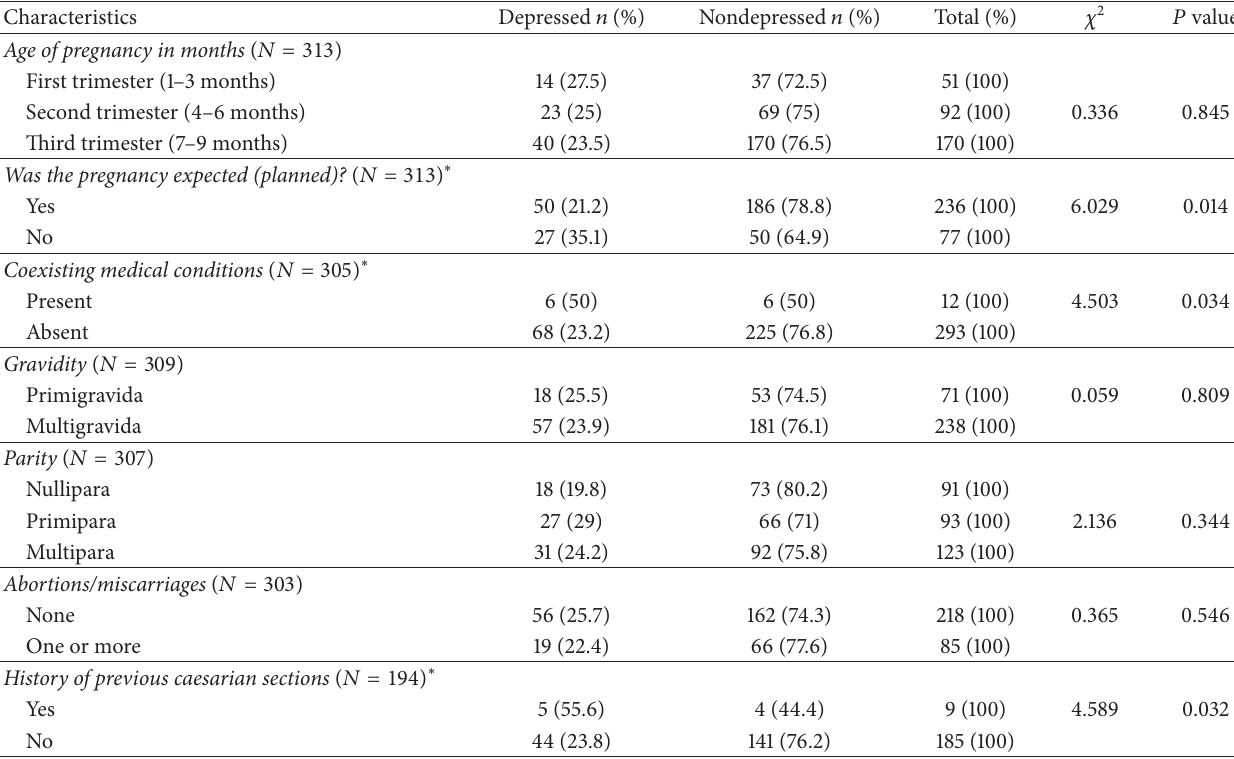
Table 4: Associations between obstetric/gynaecological variables and antenatal